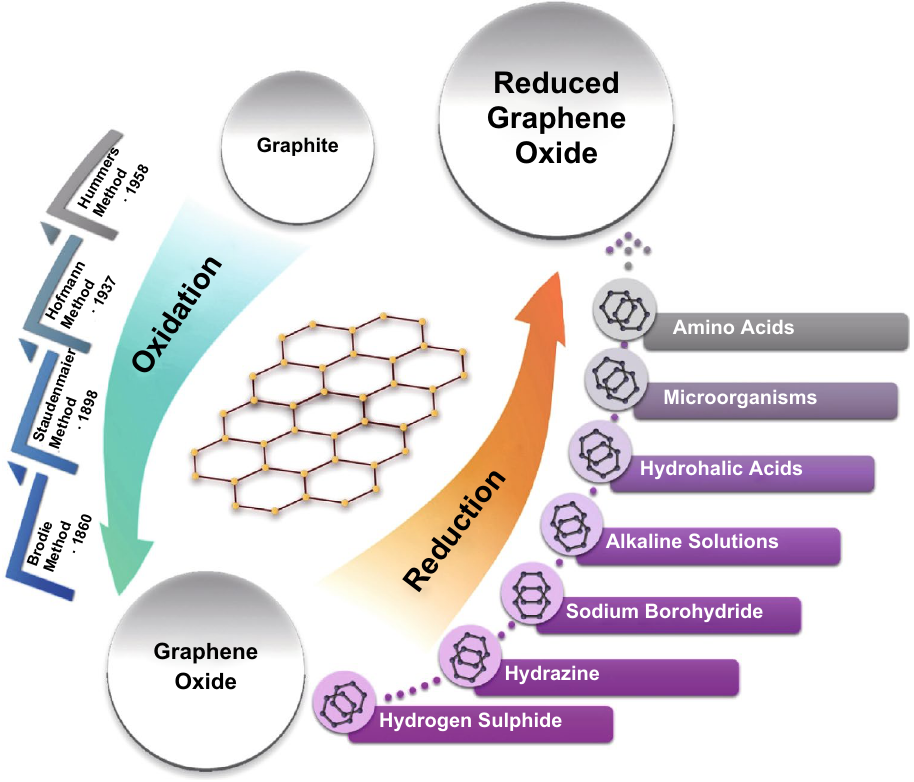
Fig. 2 Schematic representation of some of the introduced GO and rGO production